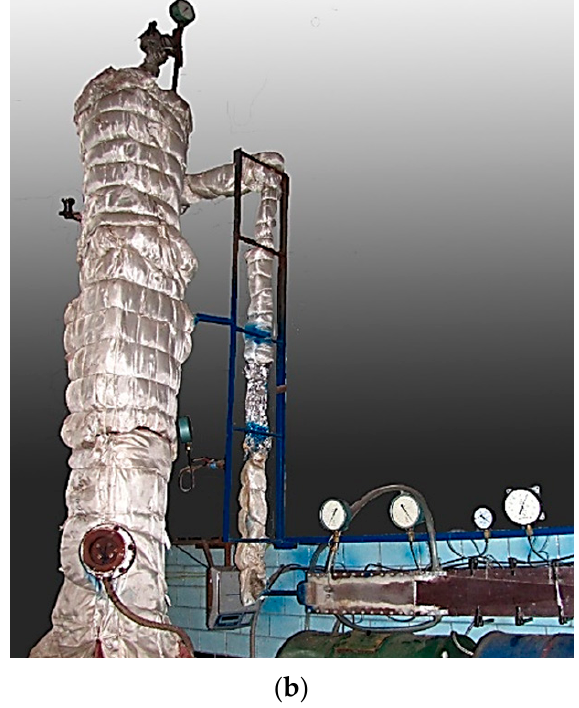
Figure 2. The ( a ) design scheme and ( b ) photo of the experimental bench for research of liquid–vapor ejector as part of a vacuum unit: 1—LVE; 2, 18—heating container; 3—safety valve; 4, 5, 11, 12, 15, 20, 24—shut-off valve; 6, 25, 29—pressure gauge; 7, 19—block of heating elements; 8—water tank; 9—circulation pump; 13, 16, 21—control valve; 14—liquid ring vacuum pump; 17—heat exchanger of the “pipe in pipe” type; 22—separator; 23—digital scales; 26, 27, 31, 34—digital multimeter; 28—mass flow meter; 30, 33—vacuum gauge; and 35—volume flow meter.